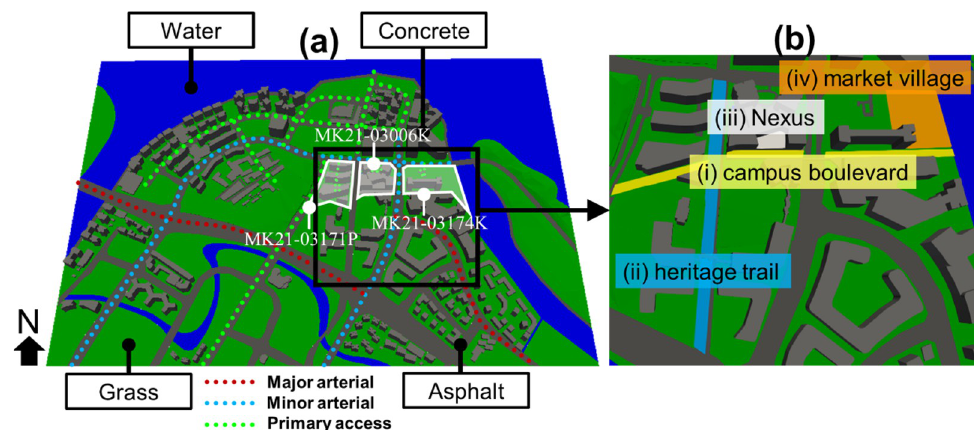
Fig 1. (a) The schematic illustration of the studied urban district in the north-east region of Singapore, including the four primary materials assigned to the 3D geometry and 3 different road categories. White portions are the planned business park with the specific lot numbers MK21-03171P, MK21-03006K and MK21-03174K. (b) The zoom-in feature of the study sites with high pedestrian traffic for the evaluation of comfort factors: (i) campus boulevard, (ii) heritage trail, (iii) Nexus, and (iv) market village.